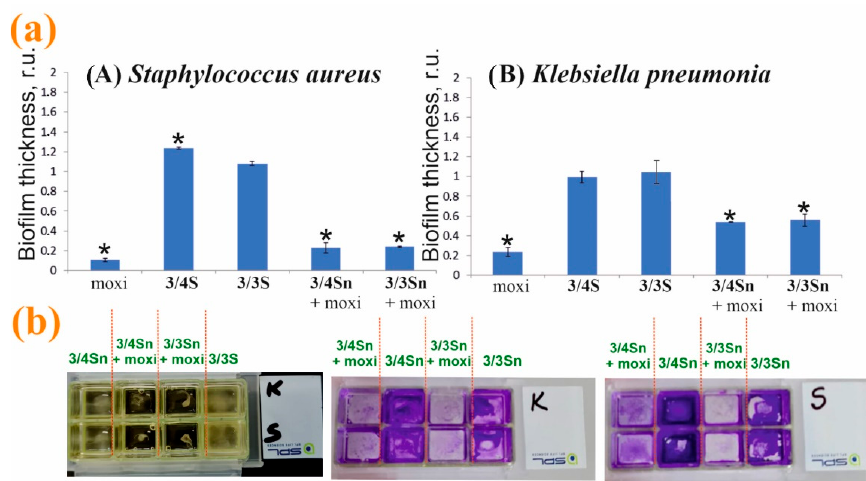
Figure 8. ( a ) Effect of pretreatment of the adhesive glass surface with 3/3Sn , 3/4Sn films and free moxi, as well as their composites with moxi on the ability to form S. aureus and K. pneumoniae bio- films. The power of the biofilm of microorganisms in the variant without pretreatment was taken as a unit. ( b ) Photographs of slide chambers with cultures of bacteria in the presence of 3/4Sn and 3/3Sn and moxi/ 3/4Sn , moxi/ 3/3Sn . *— p ≤ 0.05 when compared with the variant without pre-treat- ment of the surface.